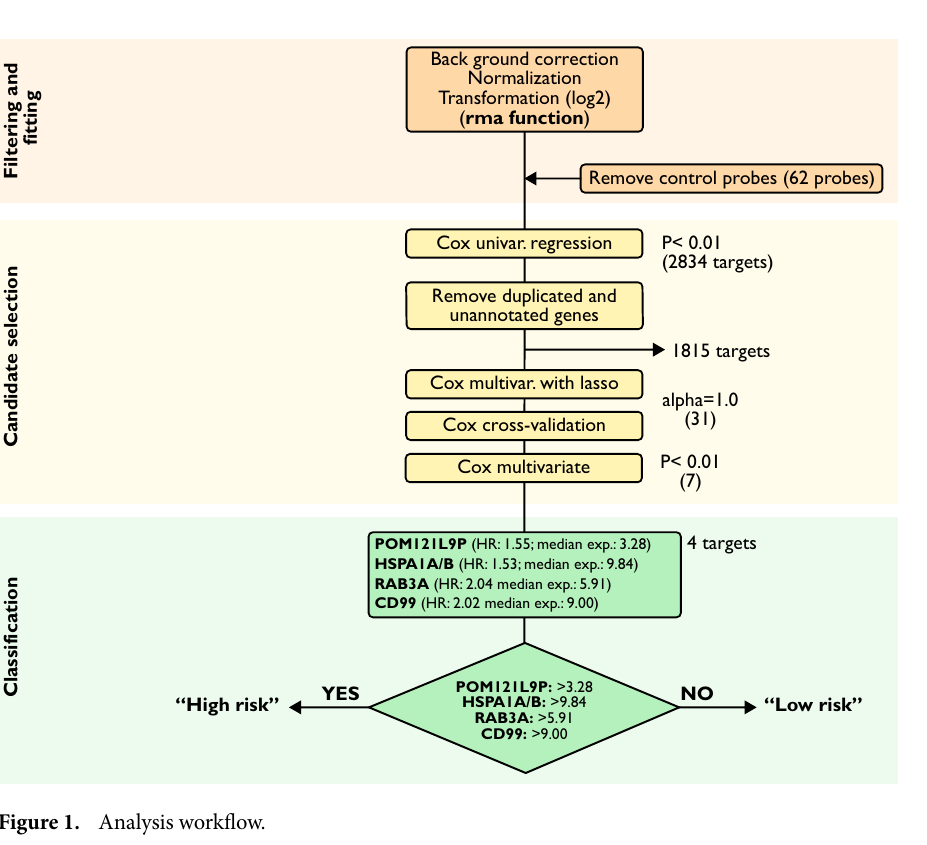
(Table 2). The overexpression of all those targets showed a significant association with poor OS of patients. The analysis workflow is presented on Fig. 1. Overexpression of candidate targets predicts poor OS and PFS.